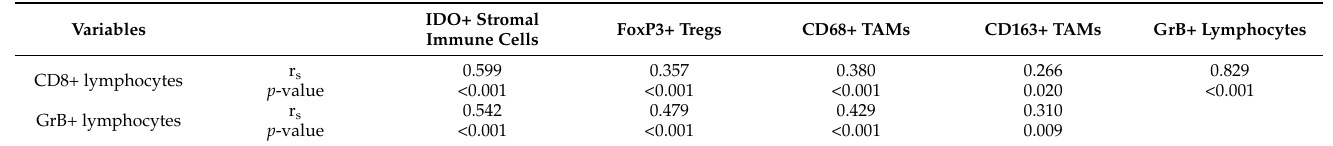
Table 4. Spearman’s correlation coefficients for CD8+ and GrB+ lymphocytes and different im- munosuppressive factors in malignant melanoma lesions. Tregs = regulatory T cells, TAMs = tumor-associated macrophages.